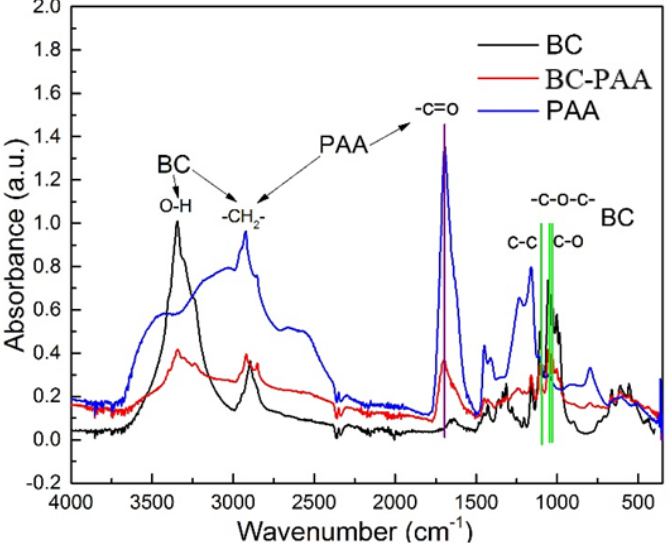
Figure 2. FTIR analysis of BC, PAA, and BC-PAA.